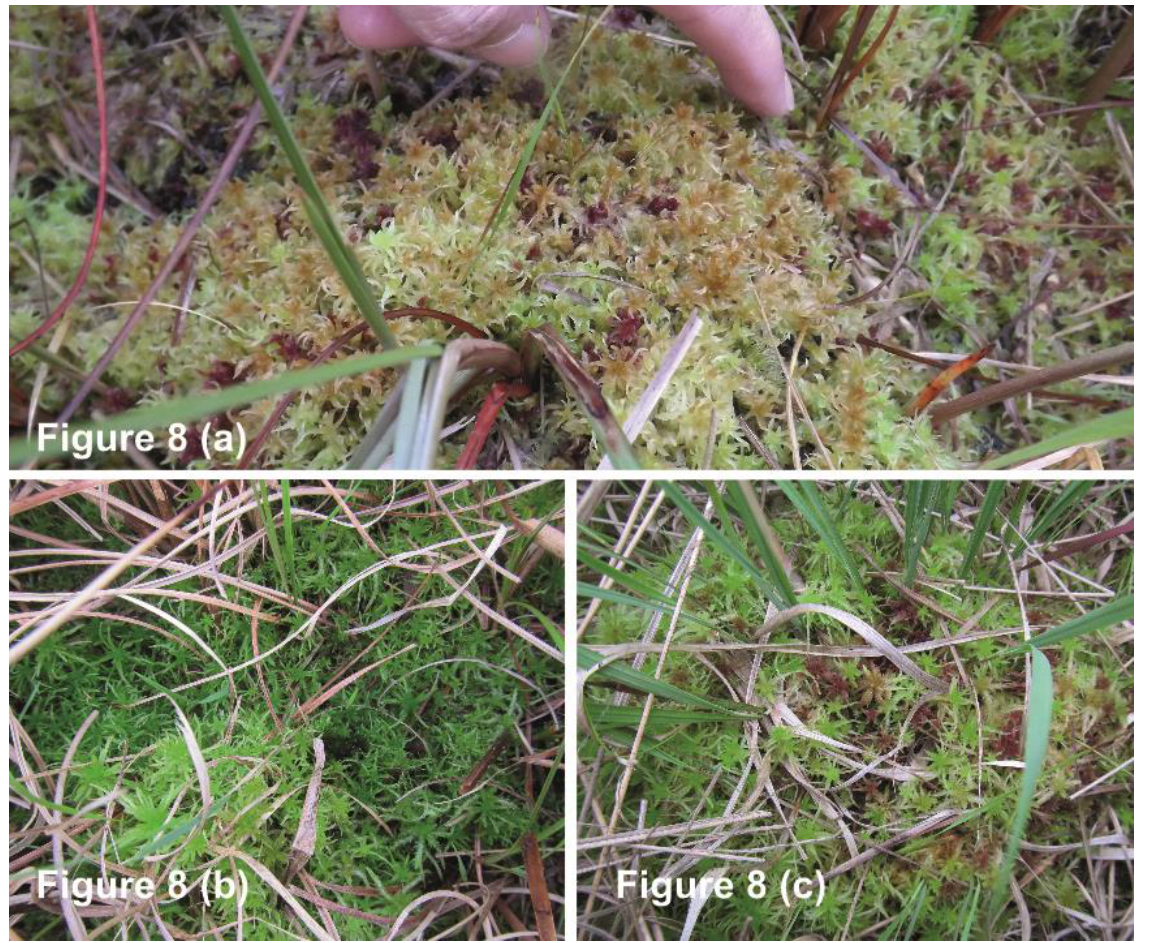
Figure 8. Three forms of Sphagnum (multispecies) at Cadishead lowland cutover peatland restoration site (Trial D): (a) BeadaGel™ planted June 2014 amongst open E. angustifolium ; (b) BeadaMoss ® planted December 2014 amongst dense E. angustifolium with no further covering; (c) BeadaHumok™ development after planting with straw mulch amongst dense E. angustifolium in December 2014; Photos May–June